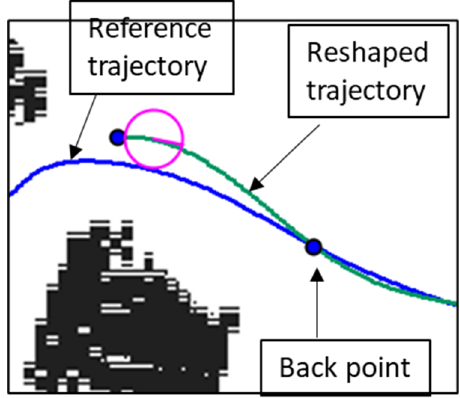
Figure 15. Visualization of re-pathed trajectory.